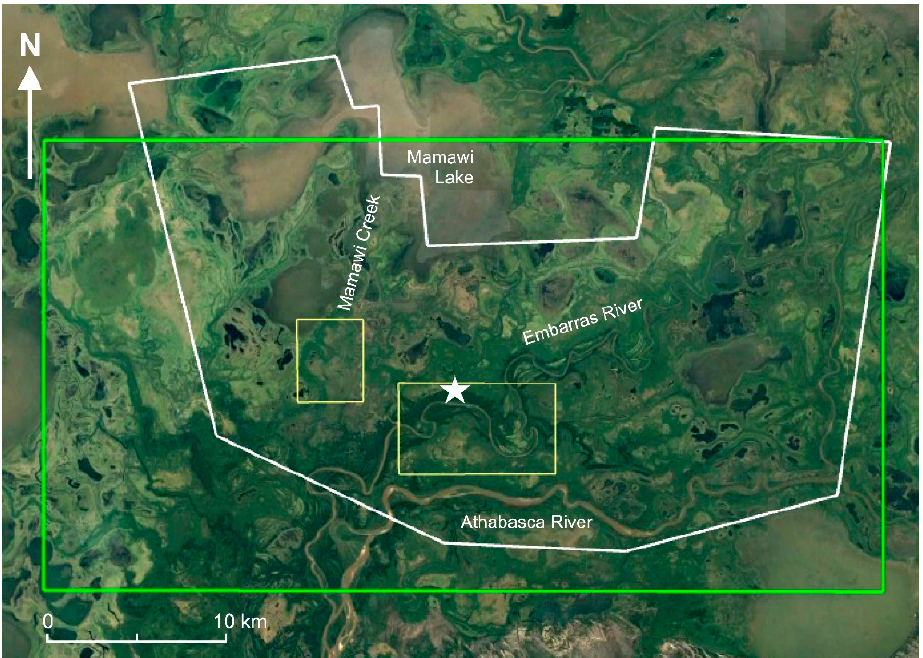
Figure 3. GoogleEarth basemap of general study extent showing (i) polygon (white) of area presented in Figure 4, (ii) polygon (green) of areas in Figure 6, and (iii) sampling point design for the current study (yellow polygons). The star indicates the location of picture shown in Figure 2.